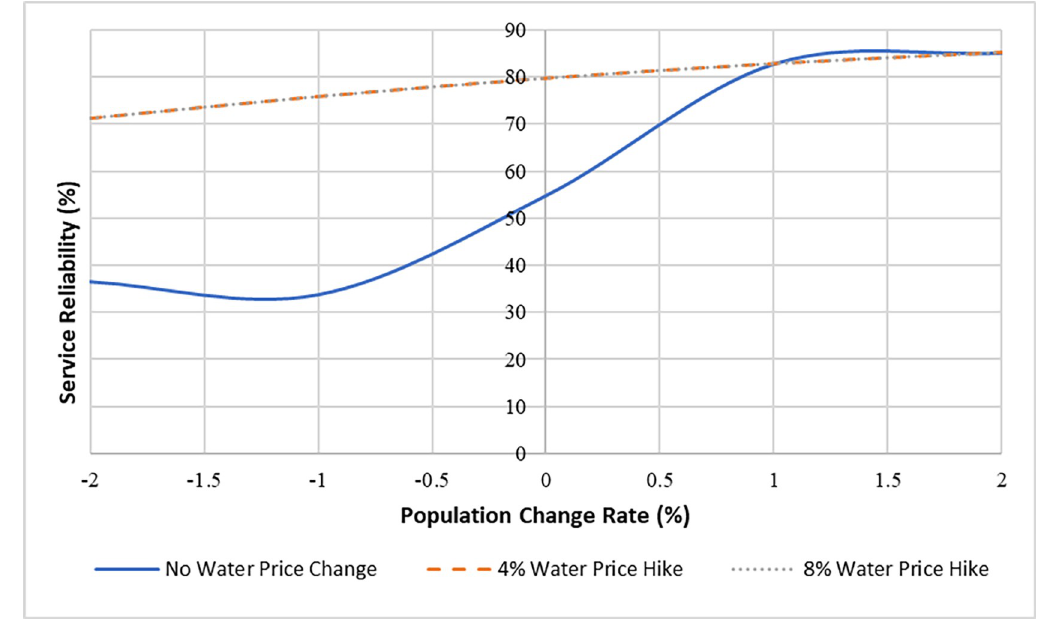
Fig 9. Impact of population change (chronic stressor) on system service